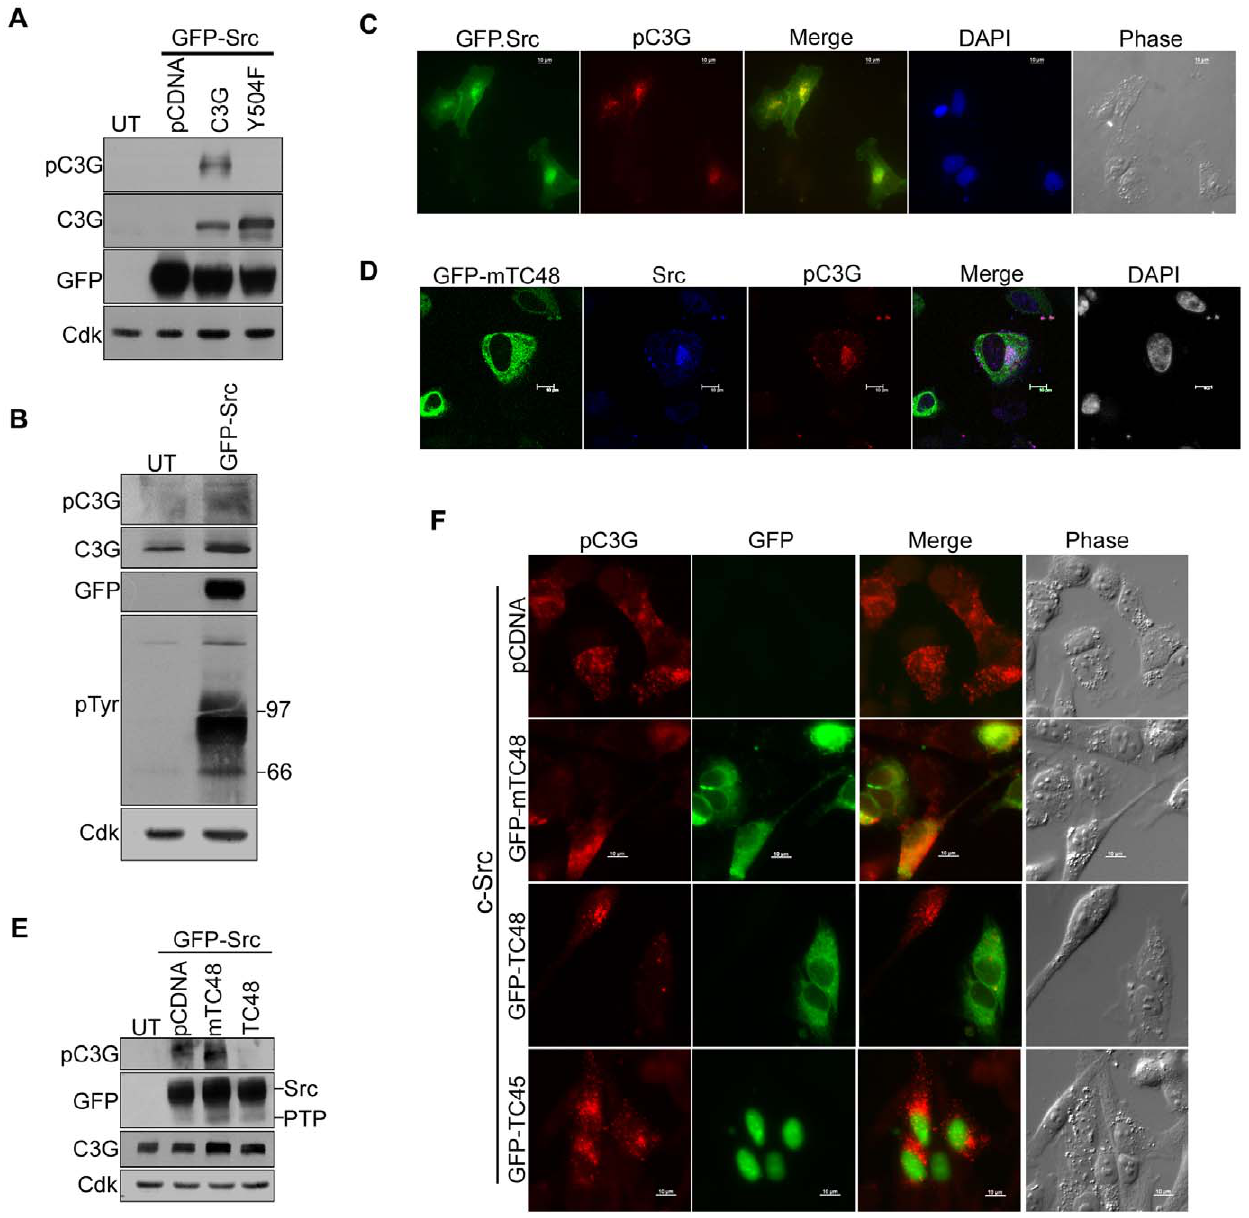
Figure 5. TC48 inhibits c-Src induced C3G phosphorylation. (A) Lysates of HEK293 cells expressing GFP-Src along with either pCDNA, C3G or Y504F mutant were subjected to western blotting with the indicated antibodies. (B) IMR-32 cells transfected with GFP-c-Src were subjected to western blotting to detect endogenous C3G phosphorylated on Y504. Blots were exposed longer compared to those in 4A, where endogenous pC3G is not detected. (C) GFP-c-Src expressing IMR-32 cells were stained for pC3G to visualize localization pattern. (D) IMR-32 cells transfected with GFP- mTC48 and c-Src were stained for indirect immunofluorescence using Src and pC3G antibodies. (E) GFP-c-Src was co-expressed with either pCDNA, GFP-mTC48 or GFP-TC48 in IMR-32 cells and lysates subjected to western blotting as indicated. (F) In situ expression of pC3G in IMR-32 cells expressing c-Src along with pCDNA, GFP-mTC48, GFP-TC48 or GFP-TC45. Bar, 10 m m.